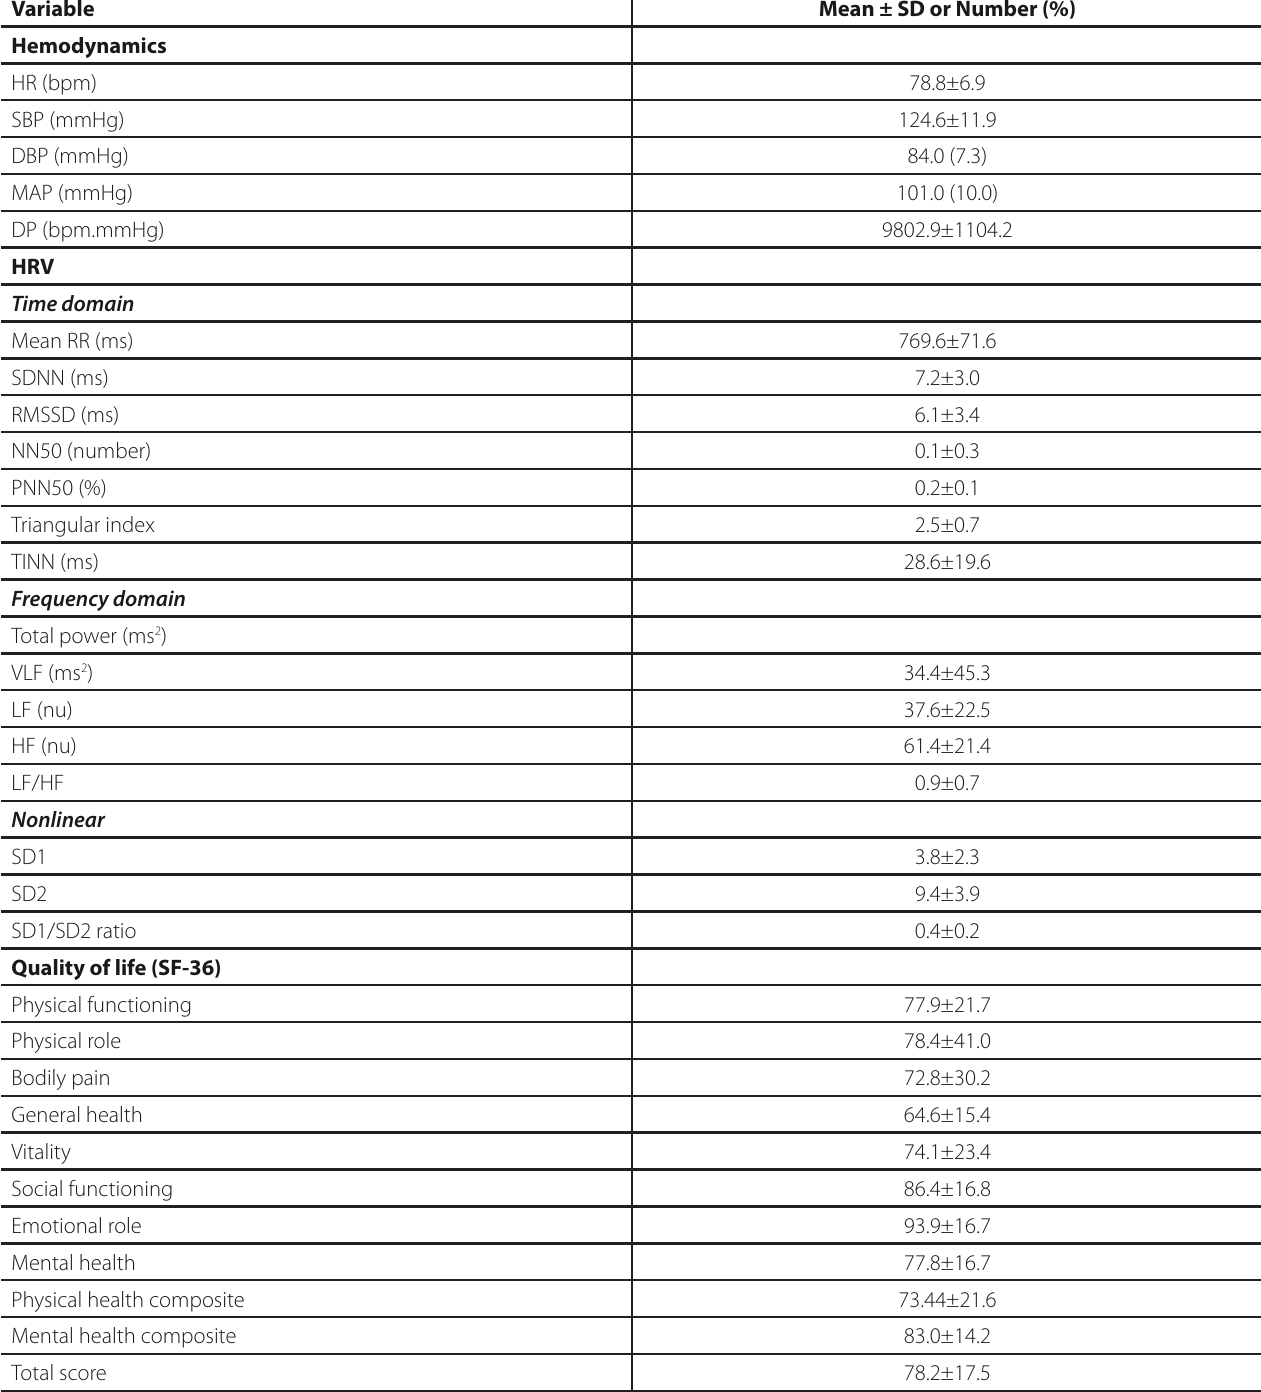
Table 1. Baseline characteristics of patients included in the